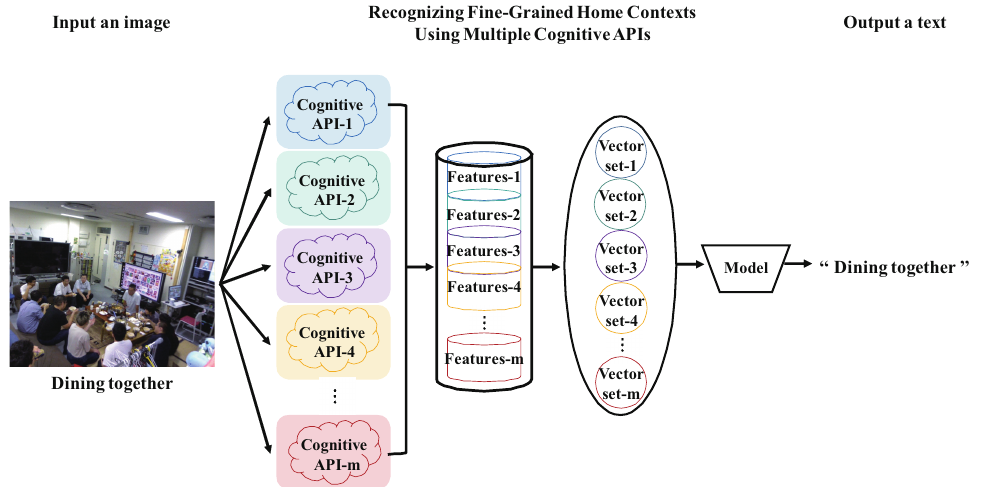
Figure 6. Example of constructing a model by combining the features of multiple cognitive